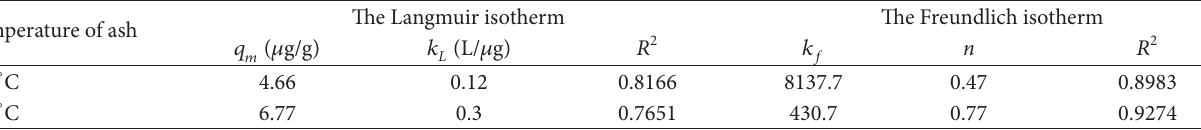
T 2: Pertinent parameters of the adsorption isotherm equations at